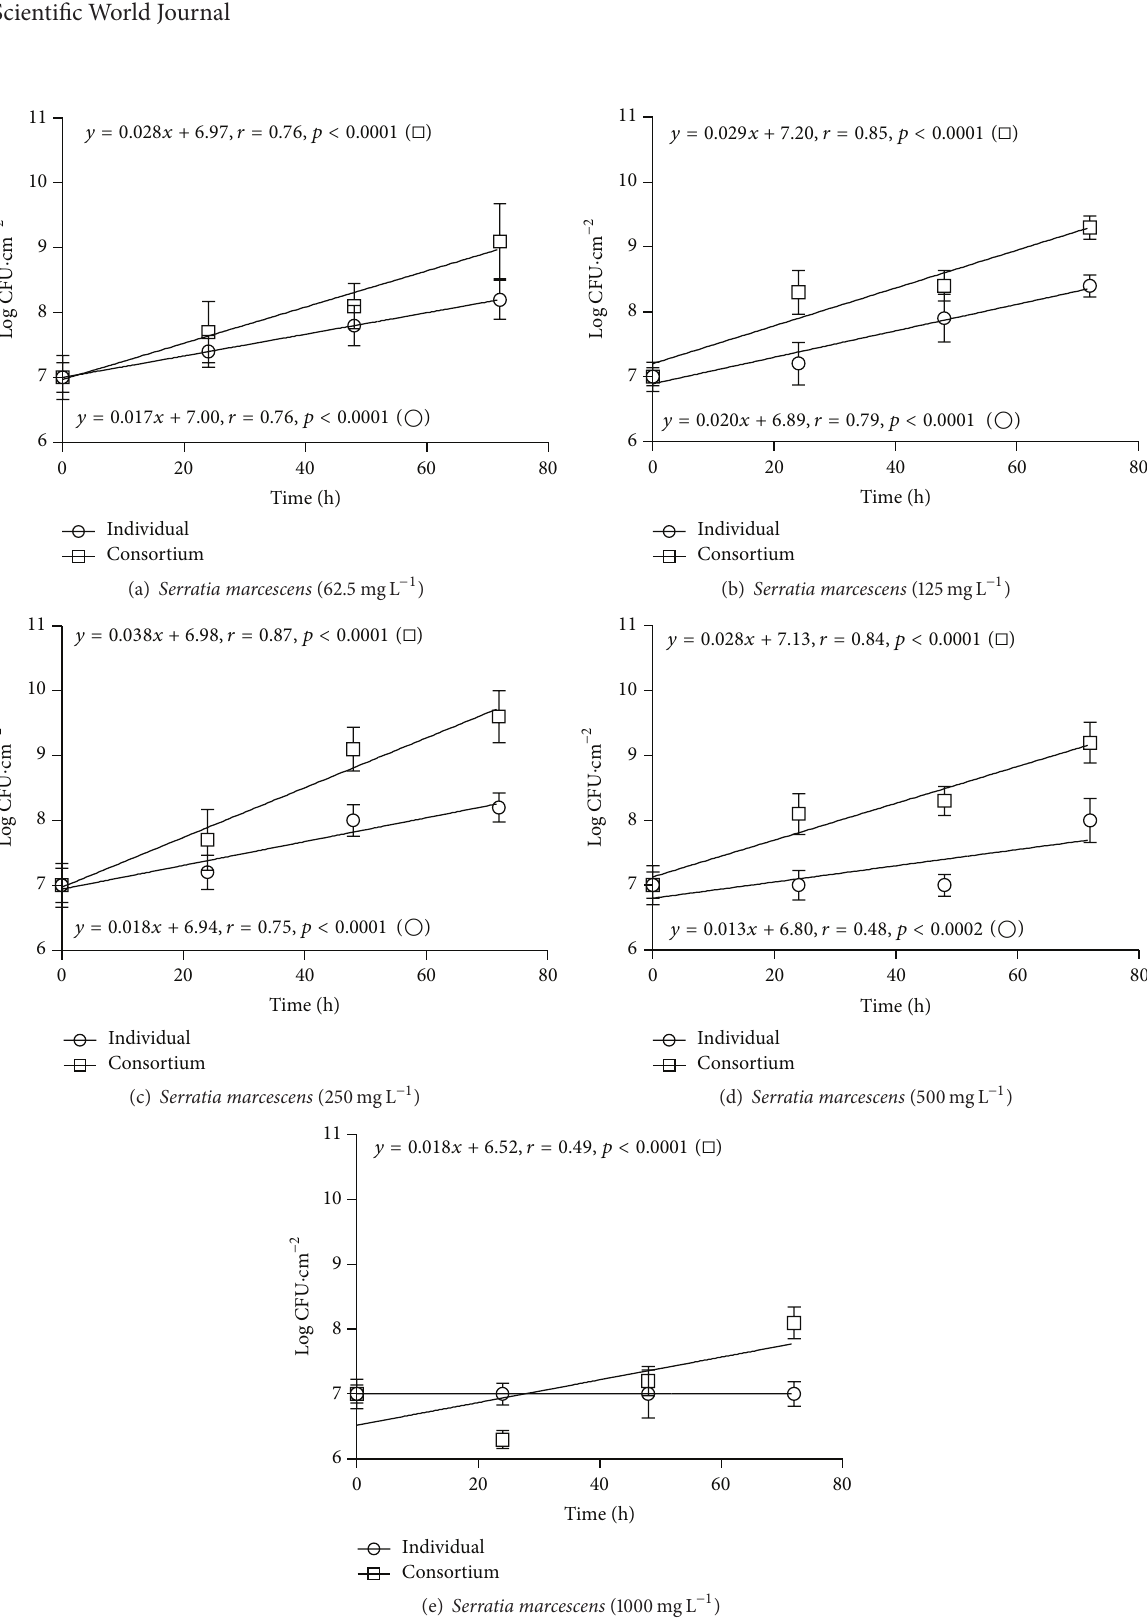
Figure 2: Growth curves of Serratia marcescens on polyurethane foam, as an individual culture ( I ) and in a consortium with Candida rugosa ( ◻ ), at phenol concentrations of (a) 62.5 mg L −1 , (b) 125 mg L −1 , (c) 250 mg L −1 , (d) 500mg L −1 , and (e) 1000 mg L −1